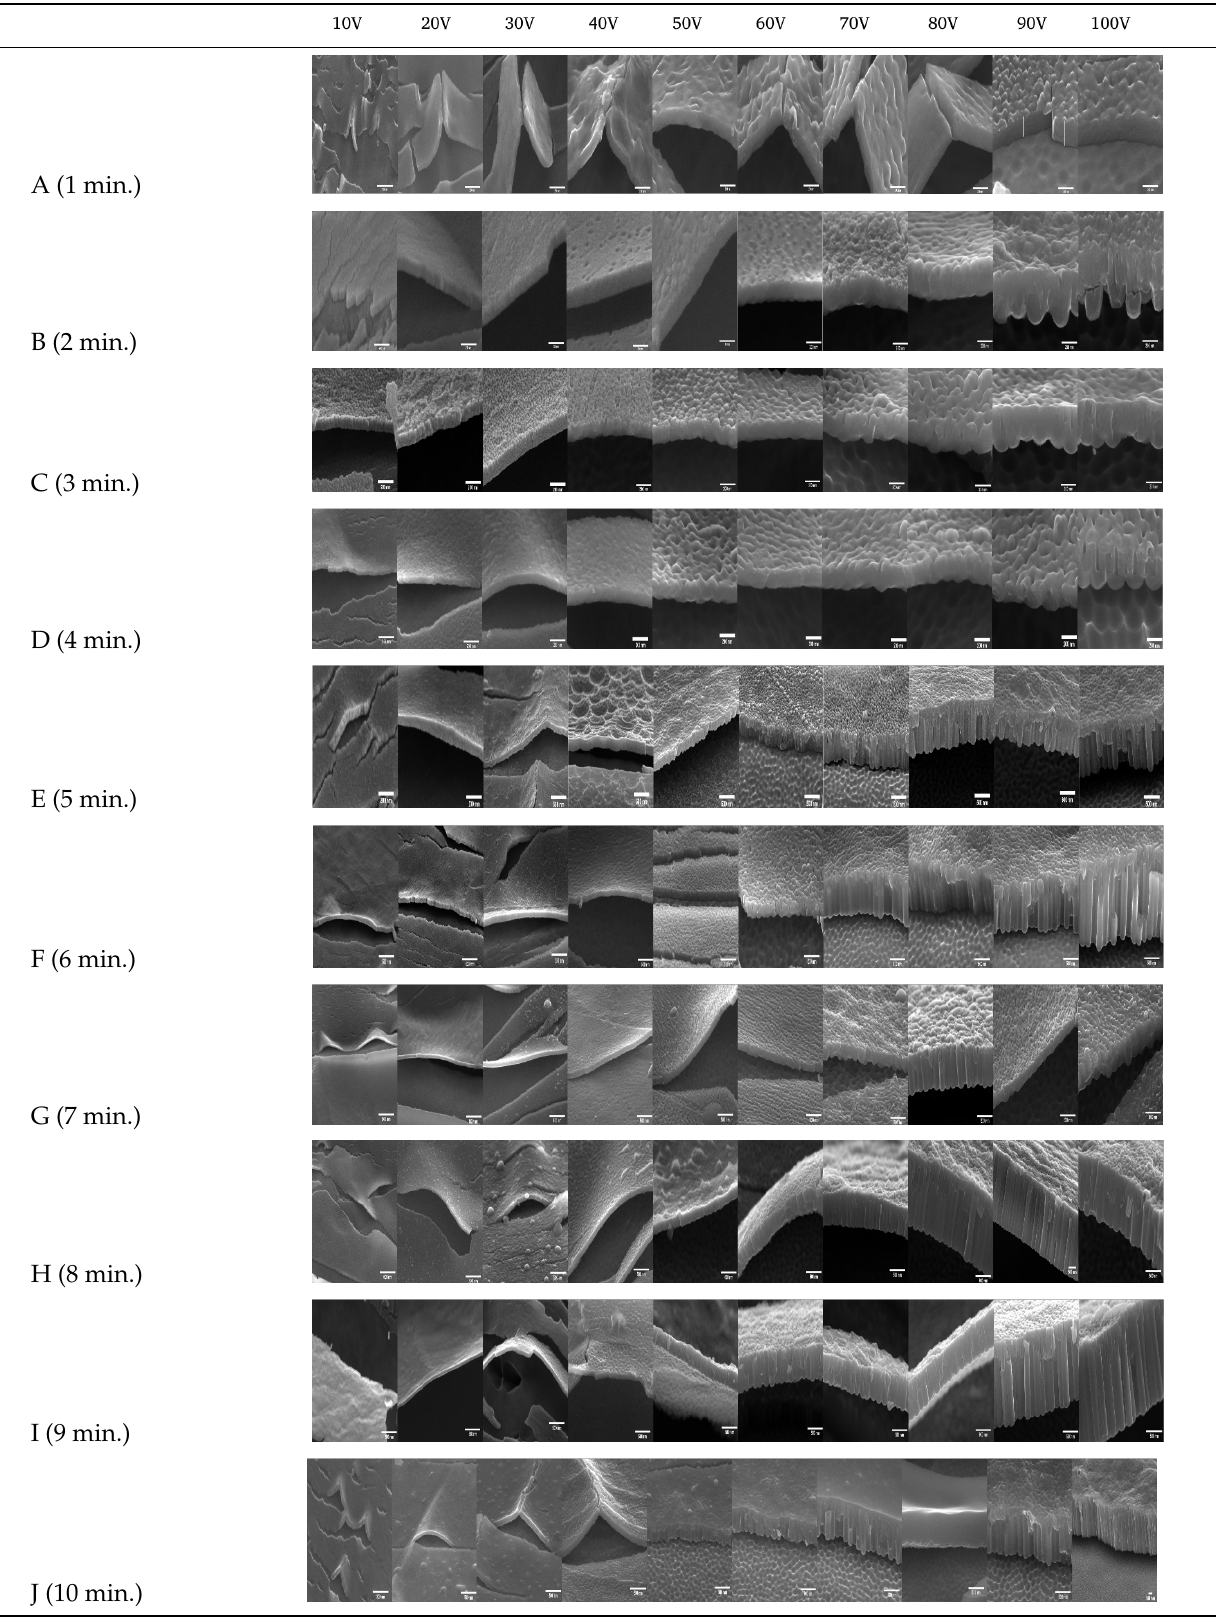
Table 2. Cross-sectional view of field emission scanning electron microscope (FE-SEM) images of TiO 2 films formed in the anodization performed at 10–100 V at the anodization time of 1–10